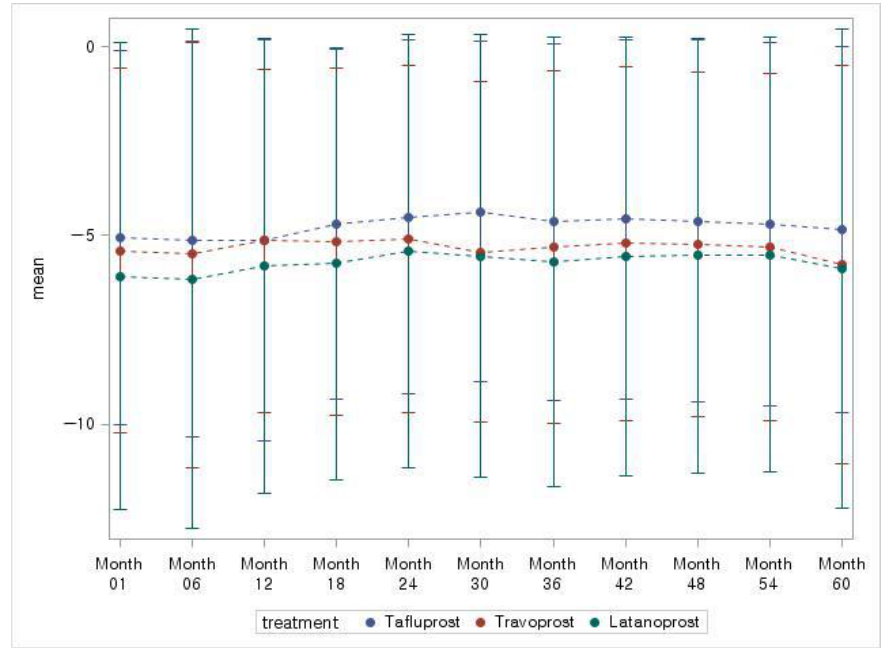
Figure 3. Time course of MD change (Match Set 2).